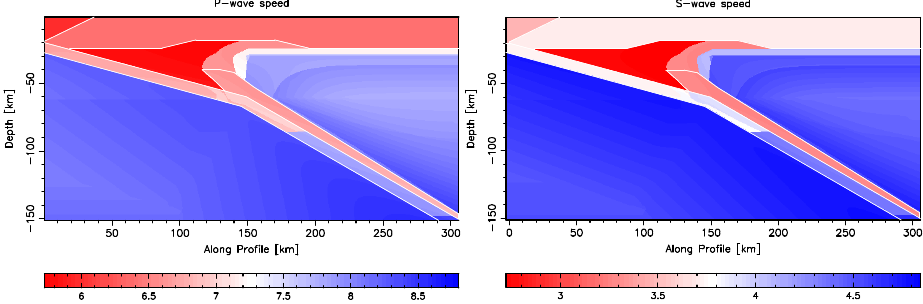
Fig. 5: Distribution of P-wave velocity and S-wave velocity for the subduction zone model including a DSC